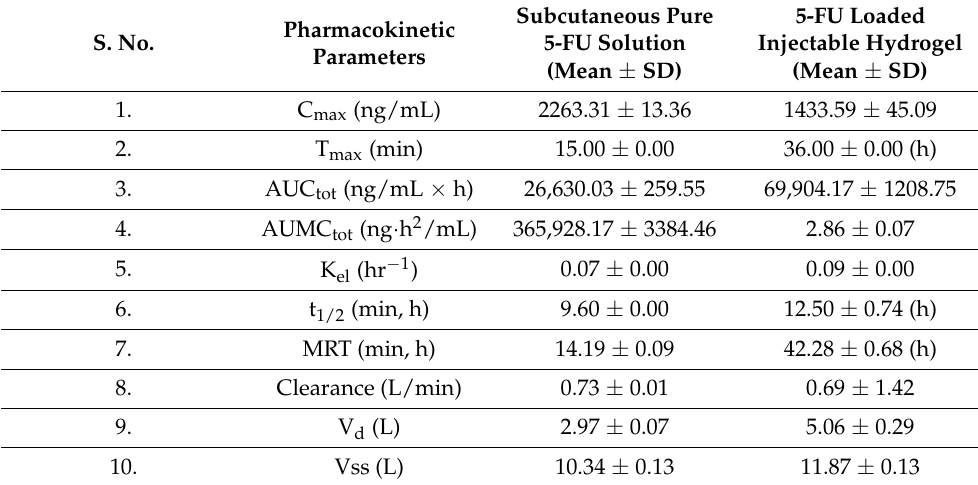
Table 6. Pharmacokinetic parameters of pure free 5-FU solution and 5-FU loaded injectable hydrogels after the subcutaneous administration to healthy rabbits of Group-A and Group-B, respectively, (n =